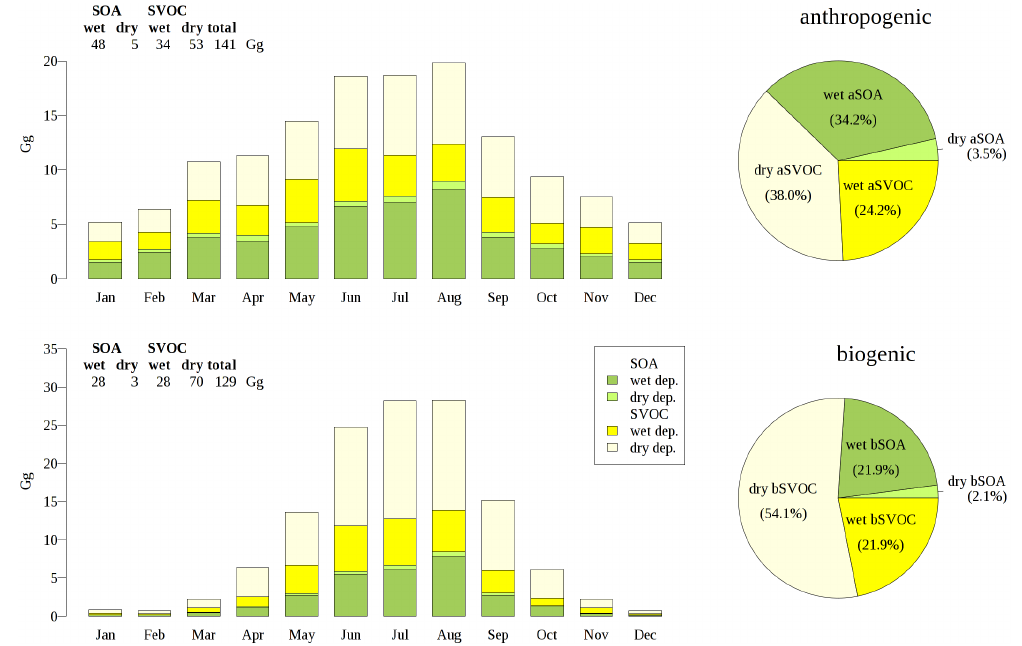
Figure 8. Monthly (left) and yearly (right) accumulated deposited mass of anthropogenic (top) and biogenic (bottom) SVOC + SOA over the continental US split into the different pathways, and shown (on the left) for simulations assuming H ∗ of SVOCs according to GECKO- A results (REF simulation). Table on top-left shows total annual deposited mass.